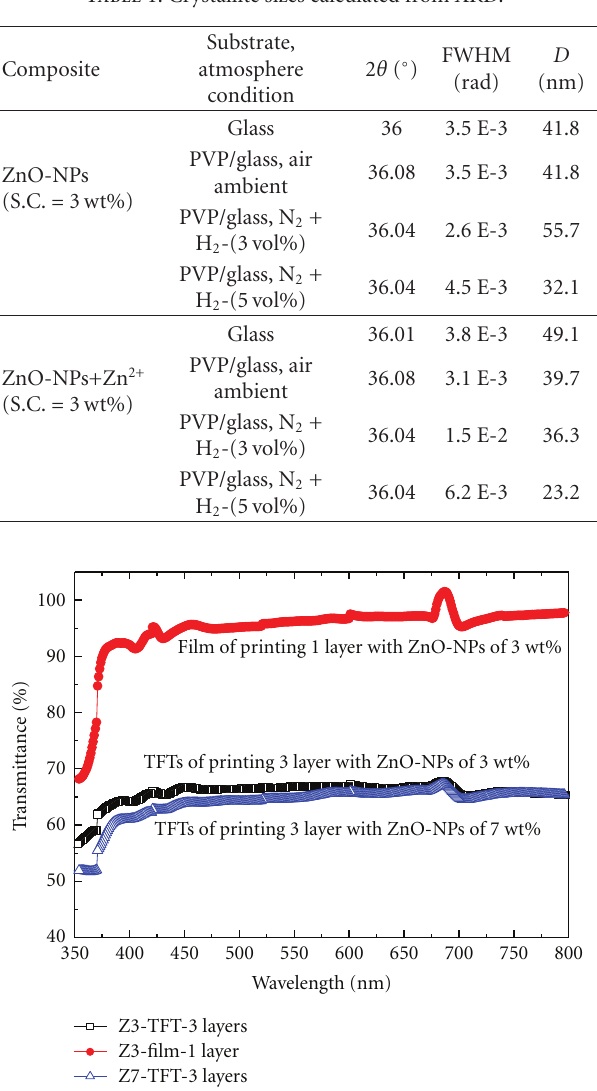
Figure 7: Plots of the measured optical transmission spectrum of the 1 layer ZnO-NPs of 3 wt% as a film; the device with 3 layer printed ZnO-NPs of 3 wt% and 7 wt%.